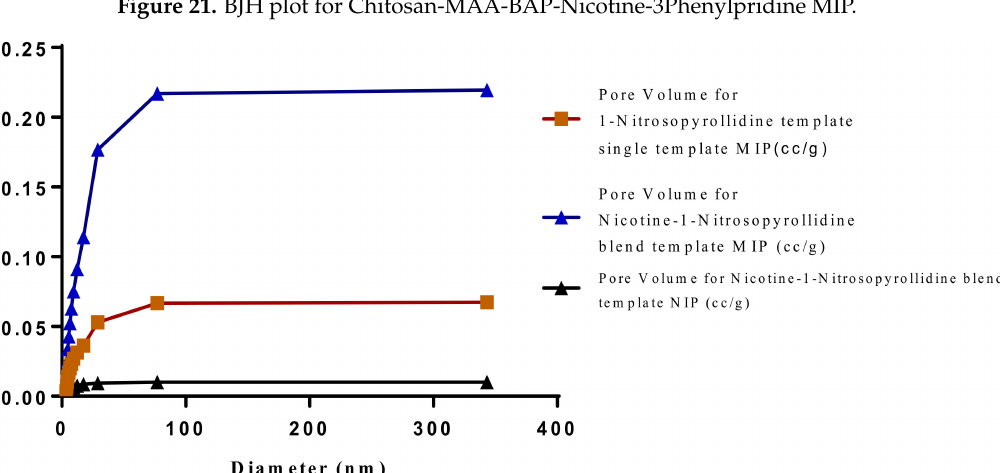
Figure 22. Pore diameter vs. Pore volume for Chitosan-MAA-BAP-3-Phenylpiridine, blend with Nicotine, and